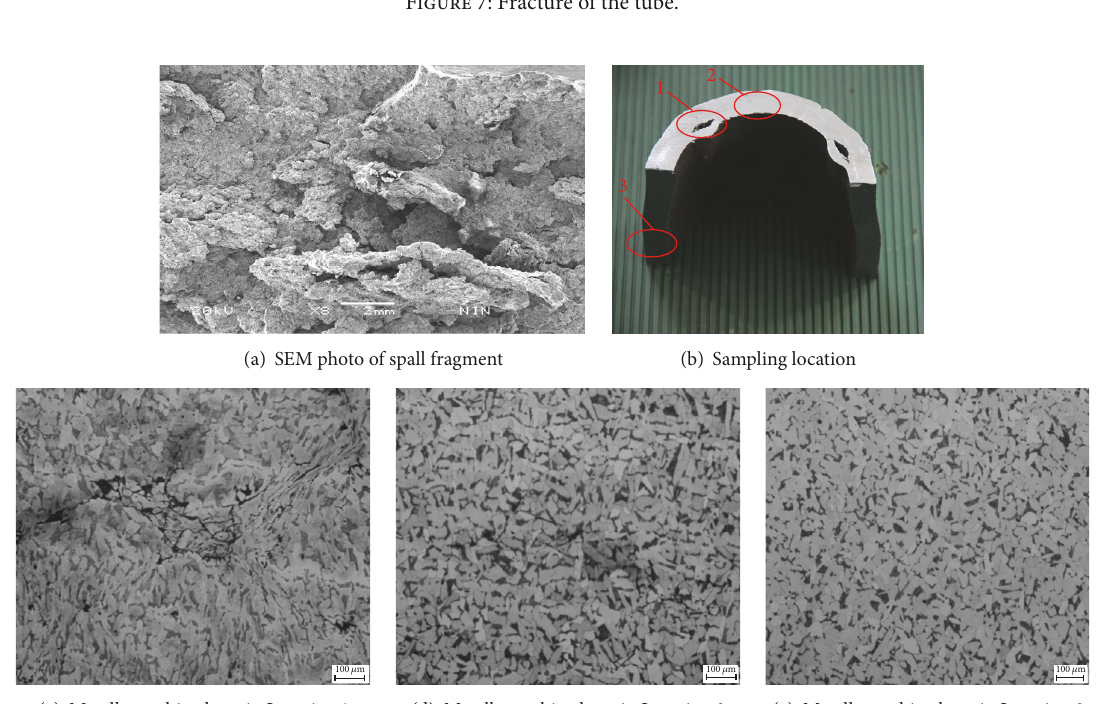
Figure 7: Fracture of the tube.